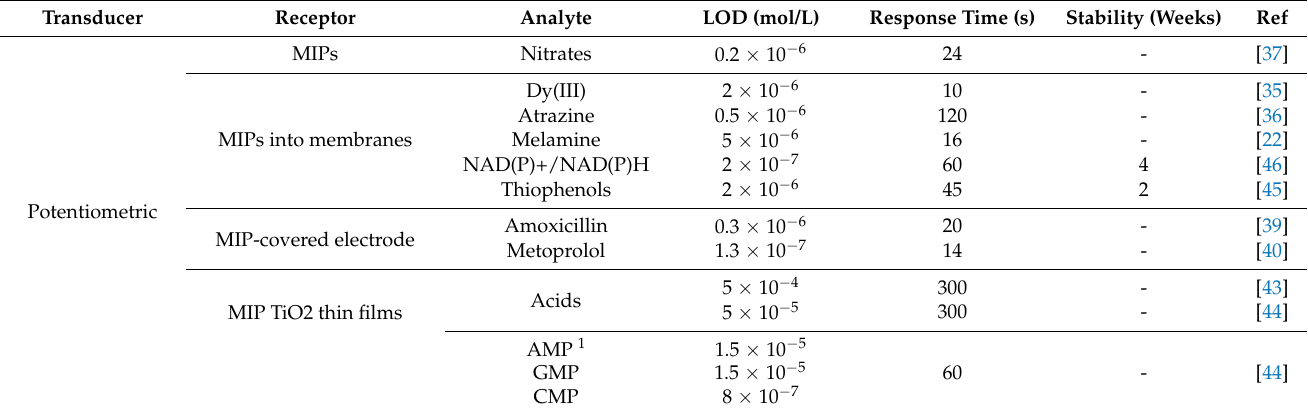
Table 1. MIP-based electrochemical